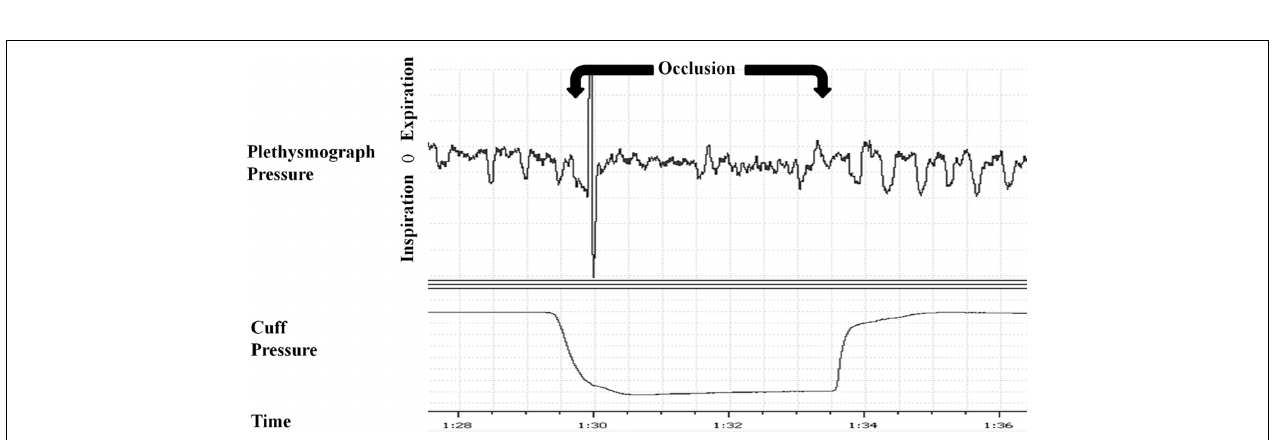
FIGURE 1 | Schematic of the experimental preparation for repeated ITTO conditioning in conscious rats. Rats were placed in a plethysmograph and the actuator tube of the tracheal cuff was connected to a saline-filled syringe.